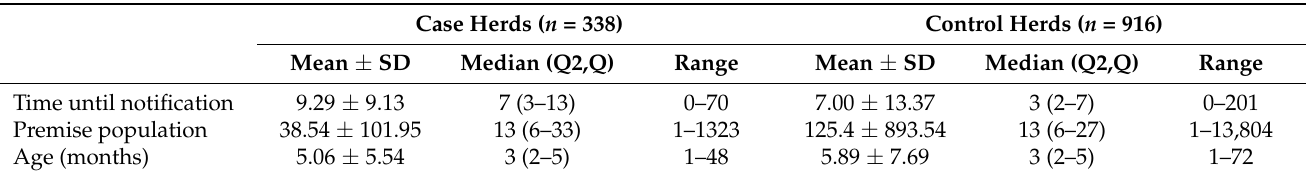
Table 2. Descriptive measures of continuous variables from the 2014–2020 CSF risk factor analysis in Ecuador.